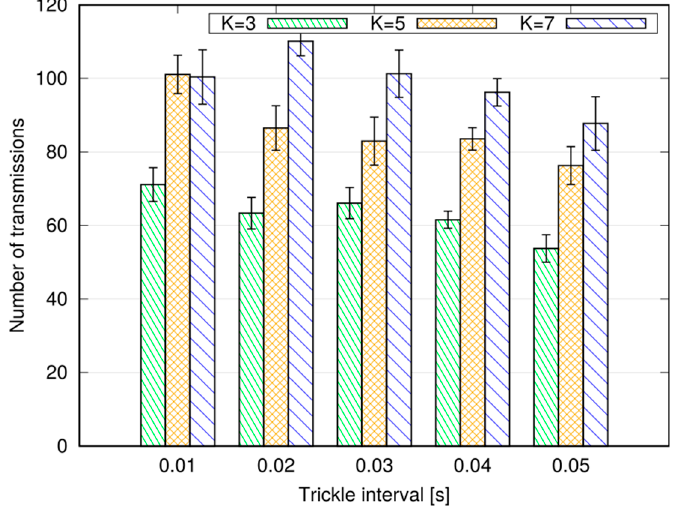
Figure 11. Average number of application-level transmissions with different settings of the Trickle algorithm.